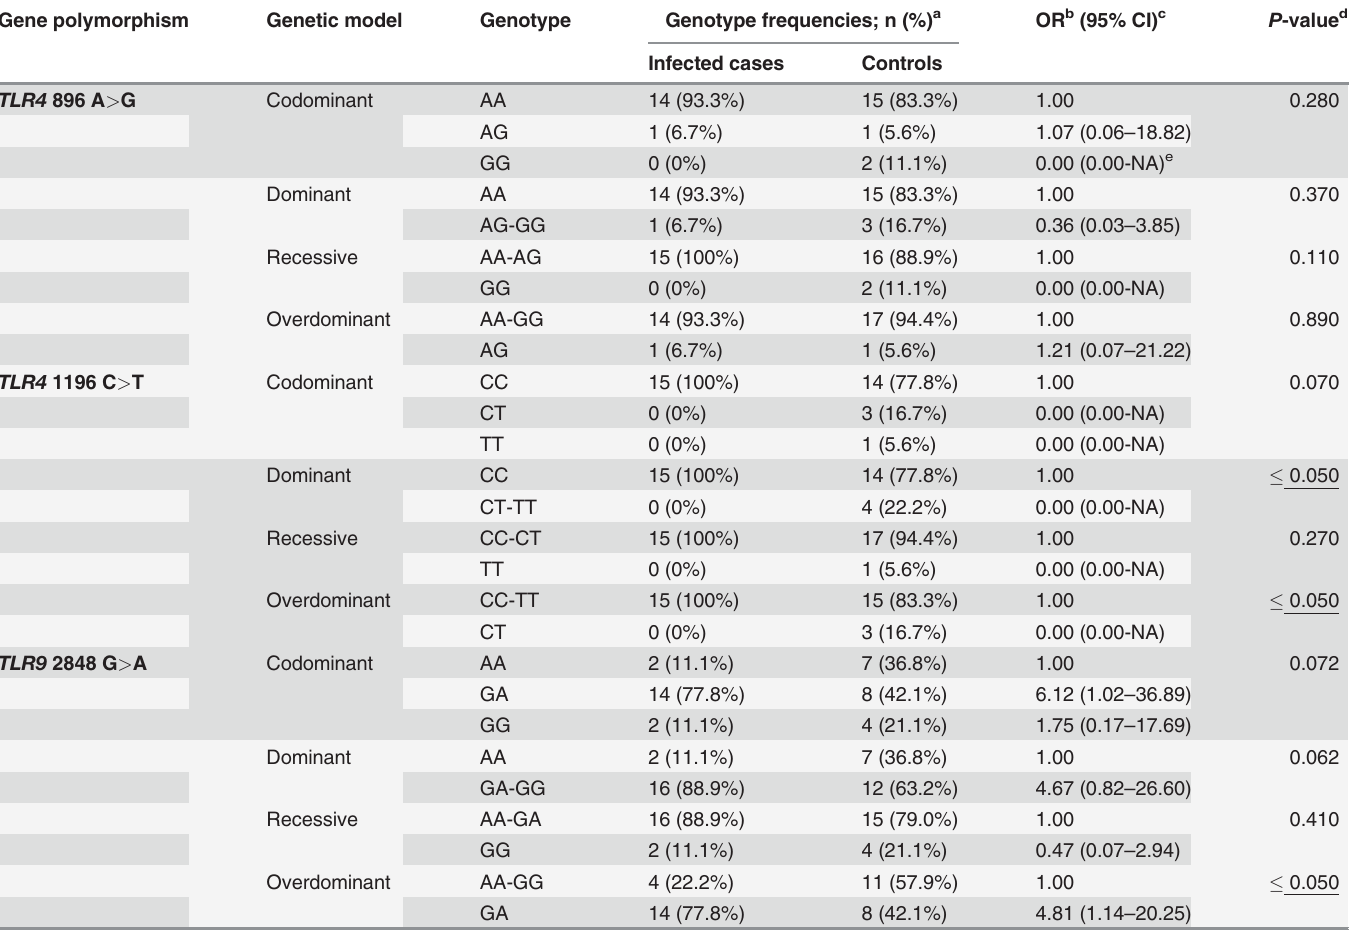
Table 3. Single-SNP analysis of the relationship between TLR polymorphisms and congenital HCMV infection. Gene polymorphism Genetic model